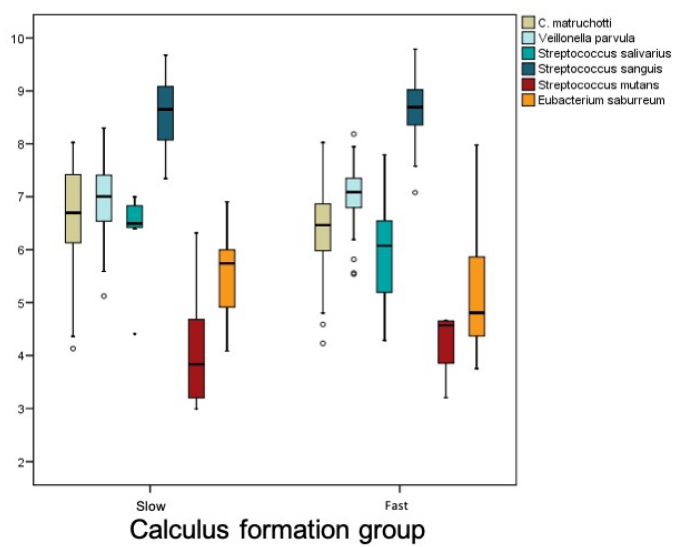
Figure 6. Bacteria distribution by group.